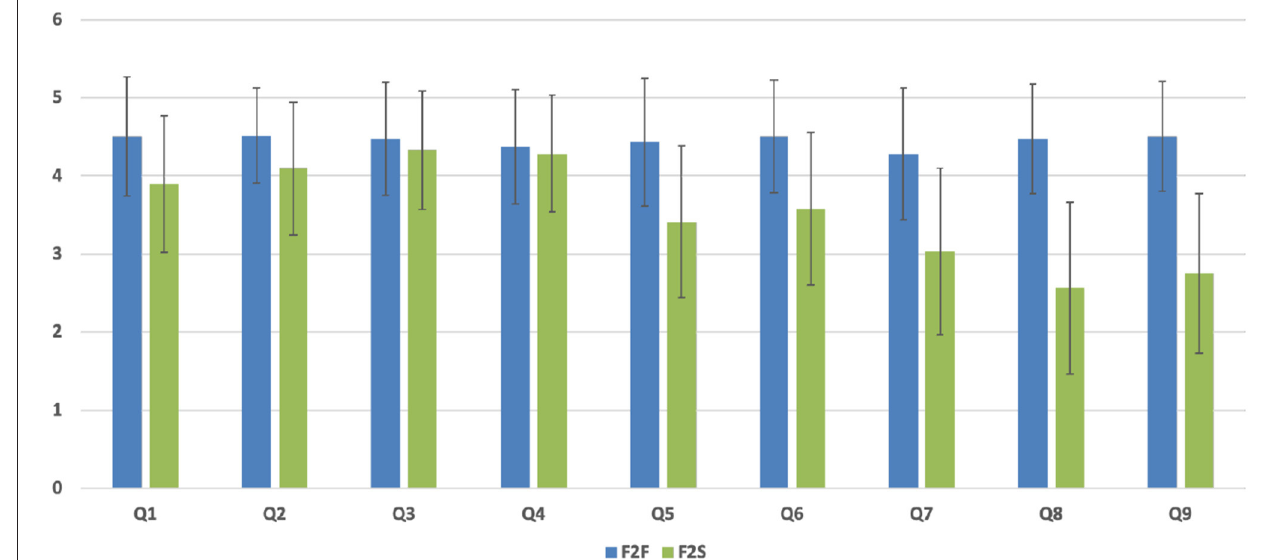
FIGURE 5 | Single item assessment of the perceptions of F2F and F2S flipped classroom after the course